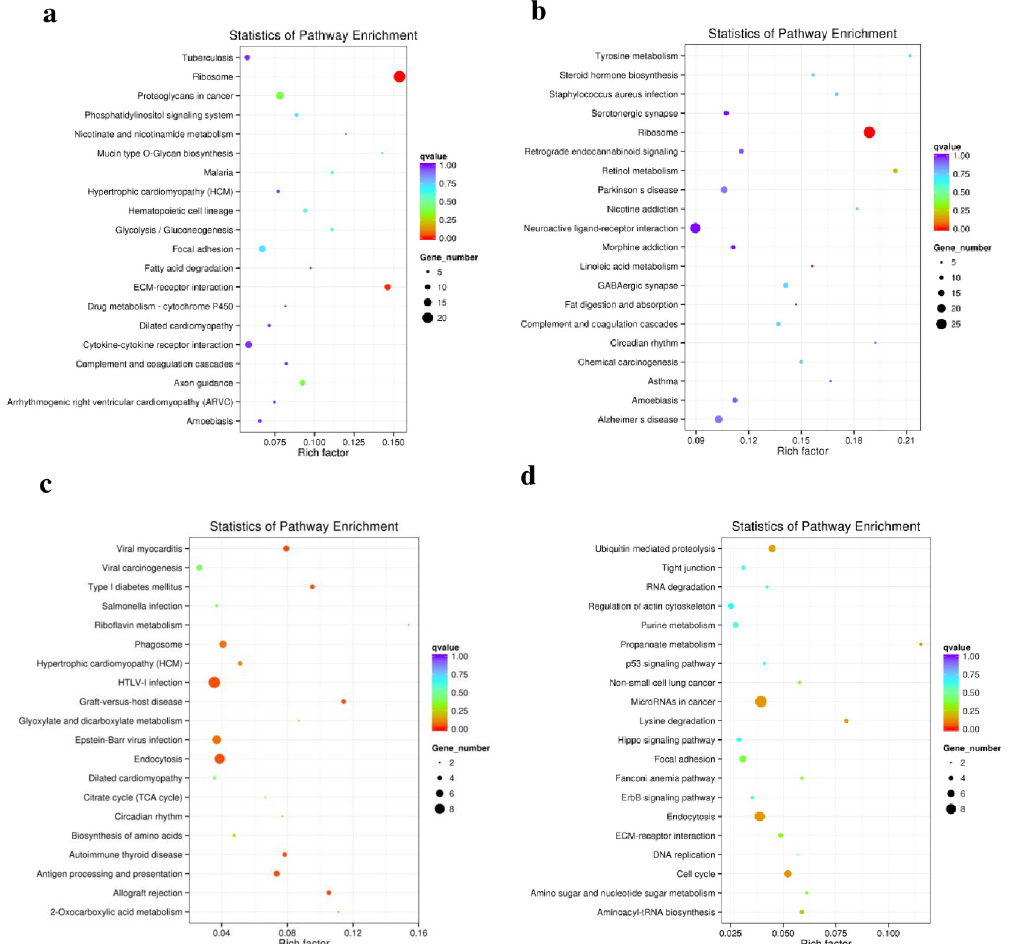
Fig 8. Kyoto Encyclopedia of Genes and Genomes (KEGG) enrichment analysis of differentially expressed genes between day 8 and day 4. (a) KEGG enrichment analysis of differentially expressed mRNAs. (b) KEGG enrichment analysis of differentially expressed lncRNAs with their trans-acting mRNA. (c) KEGG enrichment analysis of differentially expressed lncRNAs with their cis-acting mRNA. (d) KEGG enrichment analysis of differentially expressed